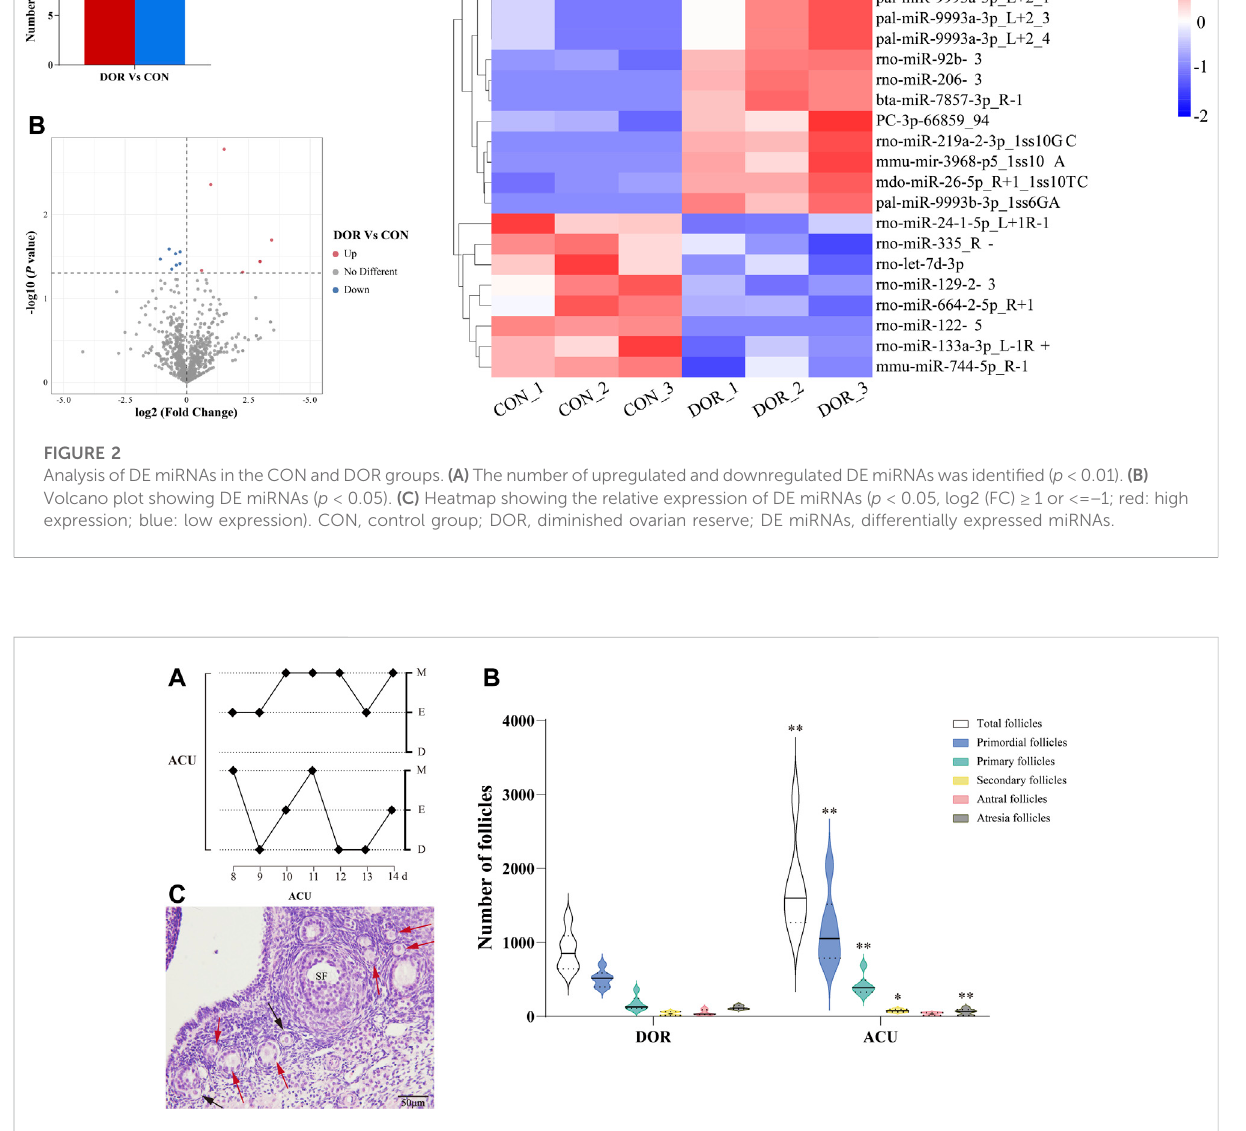
and mTOR is a key downstream target of the PI3K/AKT pathway. Therefore, we further analyzed the mTOR signaling pathway to identify target genes. The results suggested that RragB, LOC108348096, Rps6ka6, Wnt5a, Rn fl 52, Slc38a9,